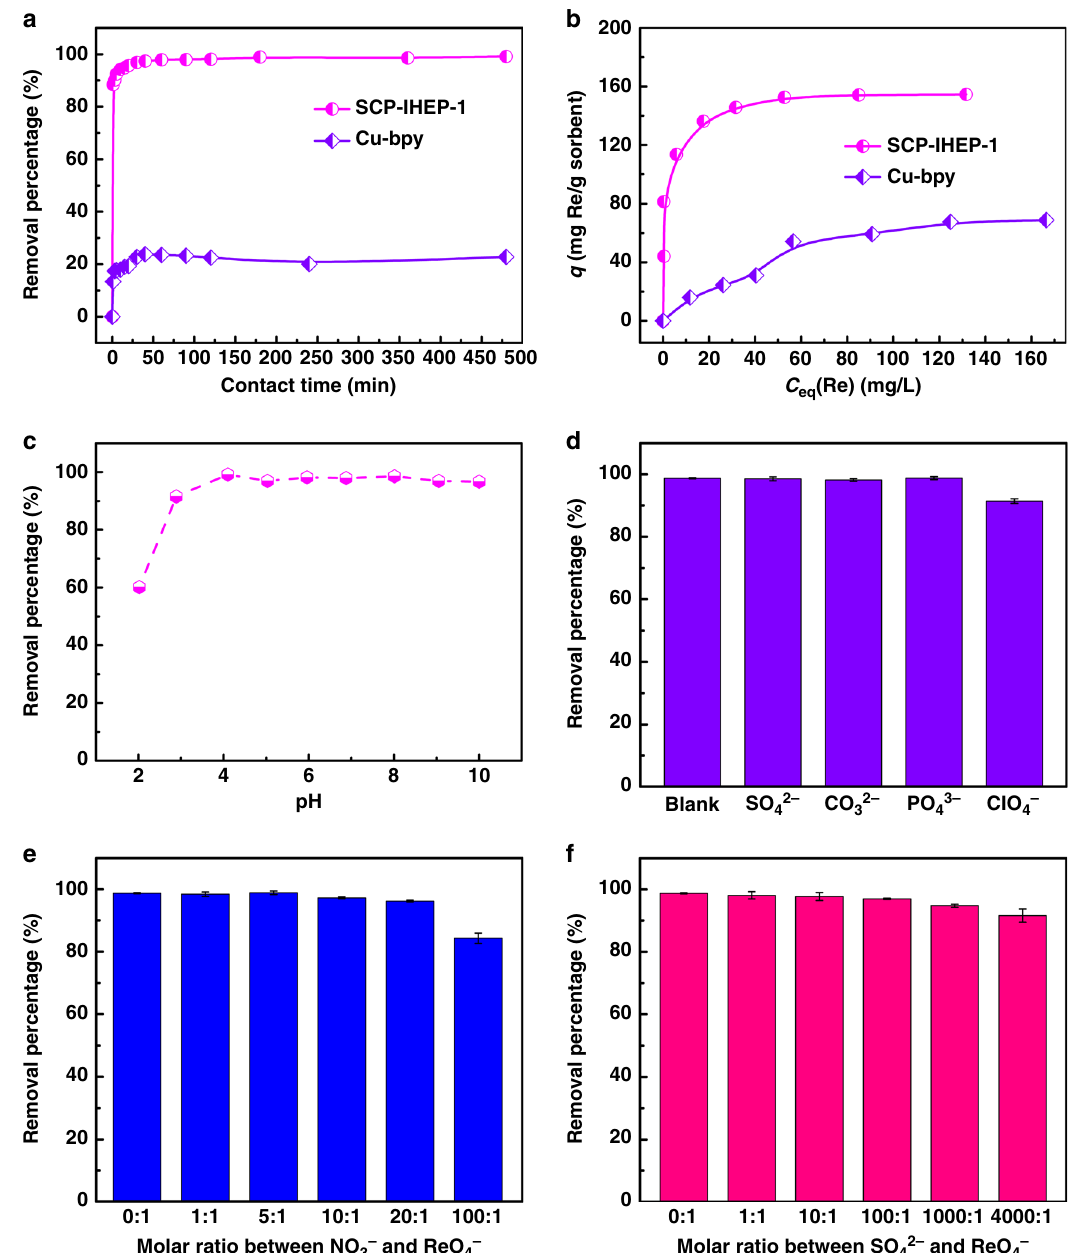
Fig. 4 Performance of SCP-IHEP-1 for ReO 4 − removal. a Sorption kinetics with that of Cu-bpy used as a comparison; b sorption isotherms with that of Cu-bpy used as a comparison; c effect of pH on the removal percentage of ReO 4 − ( c 0 = 44.6 mg L − 1 , T = 300 K, t = 12 h, V = 8 mL, and m = 4 mg); d effect of competing anions on the ReO 4 − exchange ( c 0 = 45.0 mg L − 1 , t = 12 h, T = 300 K, V = 8 mL, m = 4 mg, and pH = 6.92); e effect of excess NO 3 − on the ReO 4 − exchange ( c 0 = 45.0mg L − 1 , t = 12 h, T = 300 K, V = 8 mL, m = 4 mg, and pH = 6.85); f effect of excess SO 4 2 − on the ReO 4 − exchange ( c 0 = 45.0 mg L − 1 , t = 12 h, T = 300 K, V = 8 mL, m = 4 mg, and pH = 7.05). Error bars represent the s.d. of uncertainty for each